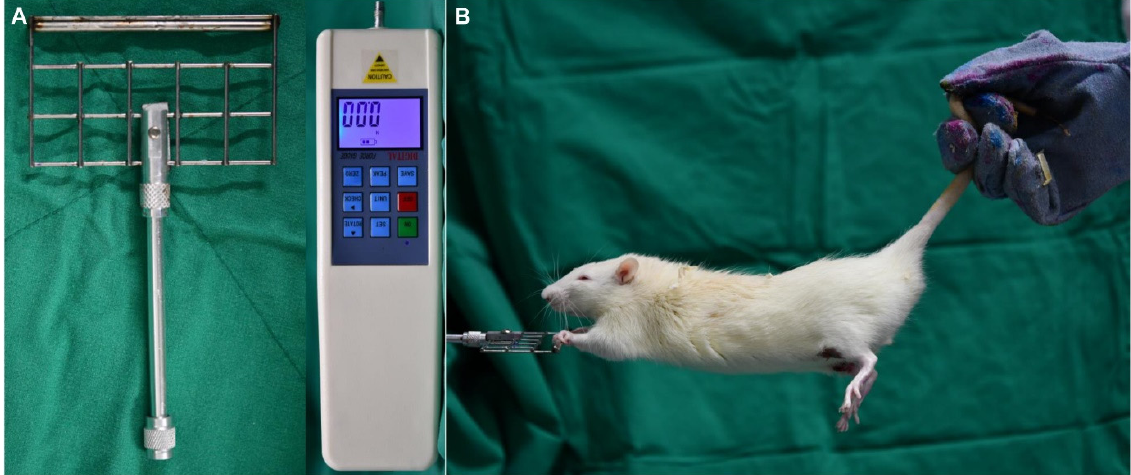
Figure 2. ( A ) Digital force transducer. ( B ) The grip strength test was repeated twice, and the average of the measured values was calculated.